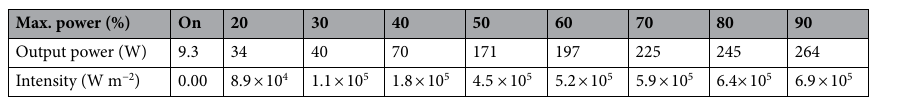
Table 1. The real power consumption of 22 mm ultrasonic probe for different percent of output and the calculated radiation intensity.